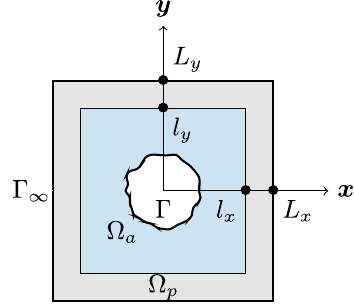
Figure 2. Computational domain X